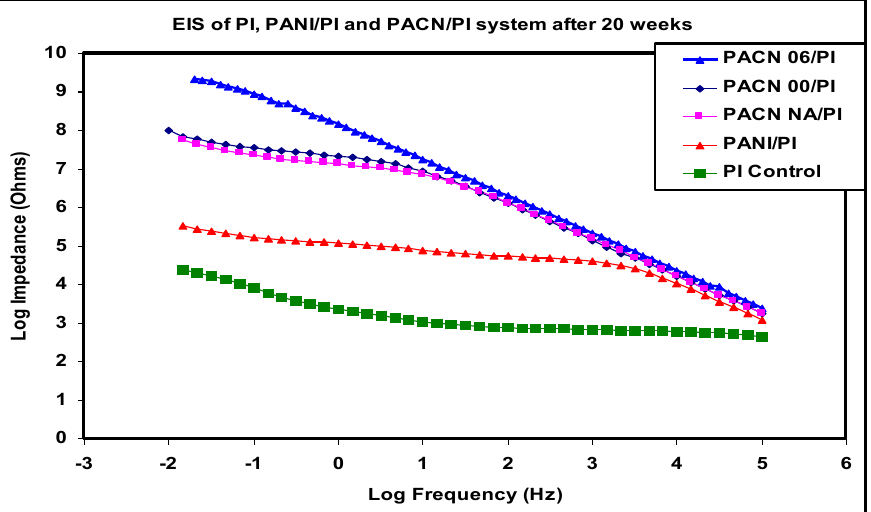
Figure 18. EIS spectra for neat polyimide coating (bottom curve), PANi/PI, (red triangle), and nanocomposite coatings containing PACN0/PI, PACNna/PI, and PACN06/PI, respectively, after 20 weeks of exposure in a 3.5 wt.% NaCl solution.